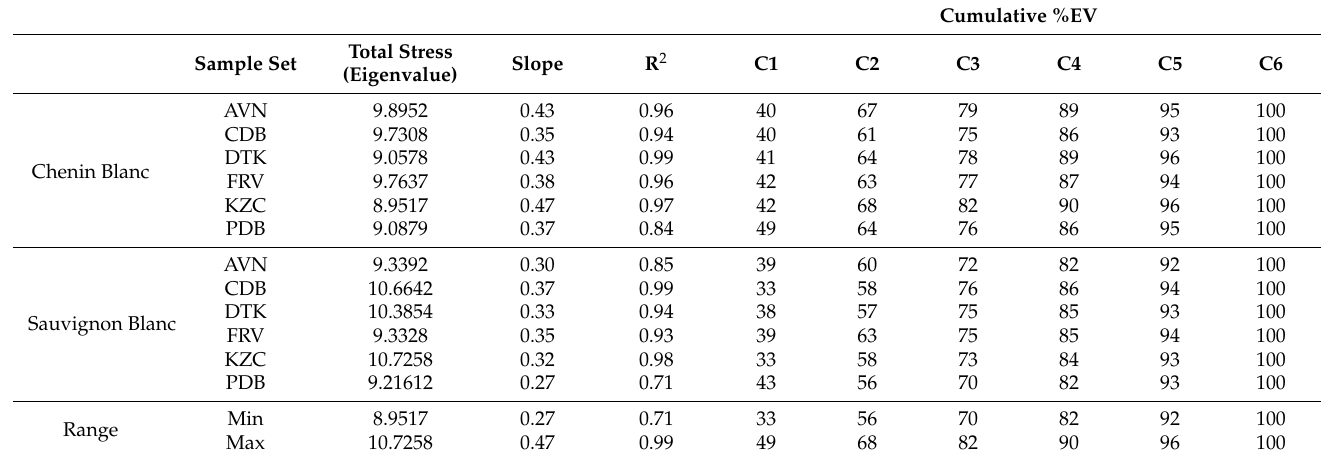
Table 6. Stress distribution over components (C) in the MFA data